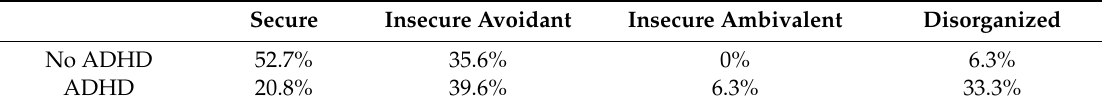
Table 1. Distribution of attachment styles in Attention Deficit Hyperactivity Disorder (ADHD) children. Secure Insecure Avoidant Insecure Ambivalent Disorganized No ADHD 52.7% 35.6% 0% 6.3% ADHD 20.8% 39.6% 6.3%